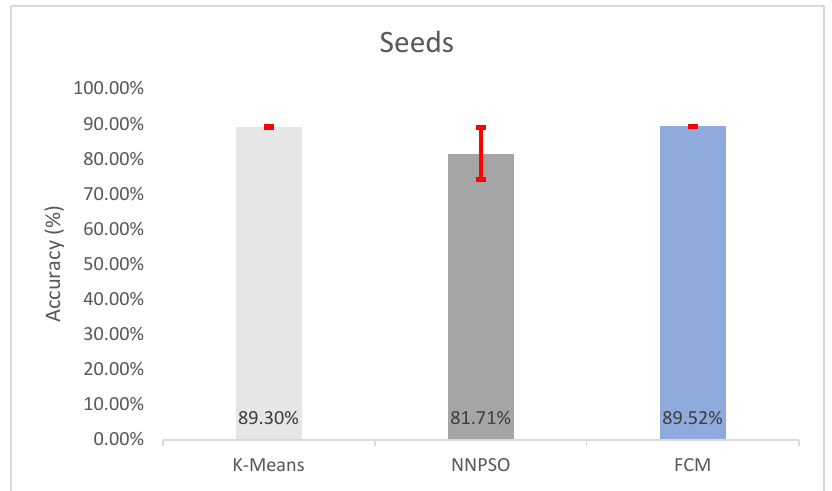
Figure 21. Accuracy of the algorithms on the Breast Cancer data set.